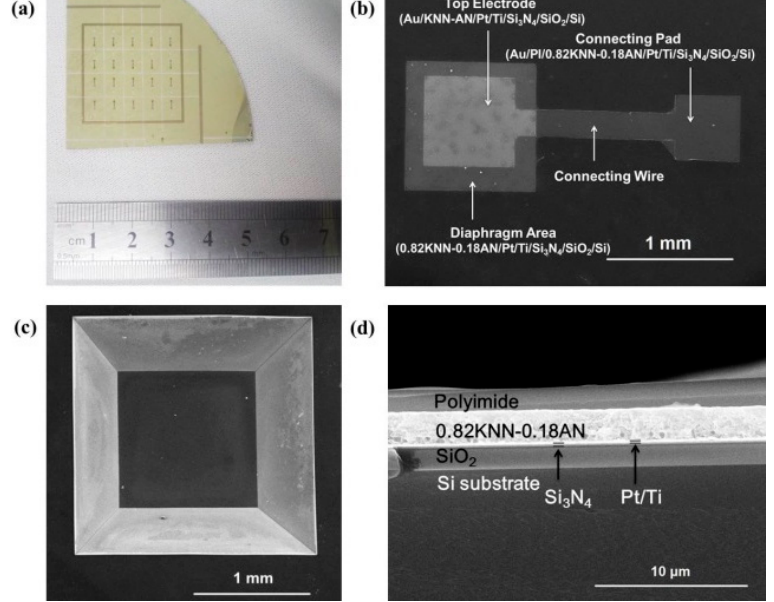
Figure 4. ( a ) Optical image; SEM images of the ( b ) front view; ( c ) back view; and ( d ) cross section of the fabricated biosensor.